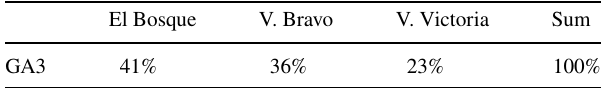
Table 9 The percentage of annual total extraction supplied by each reservoir, found with genetic algorithm (GA3) El Bosque